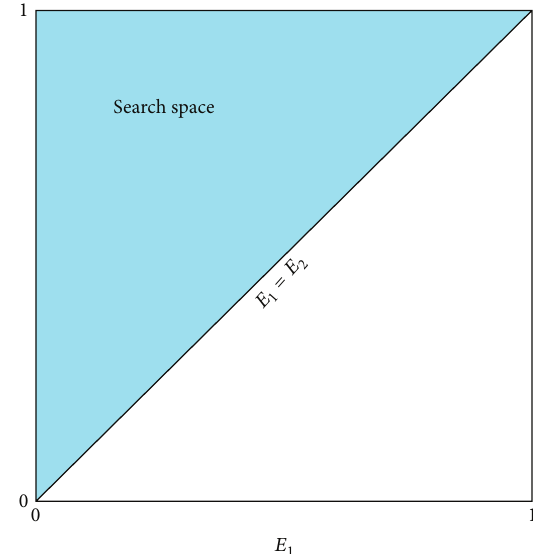
Figure 4: Search space for optimization to determine the values of 𝐸 𝐸 1 and 2